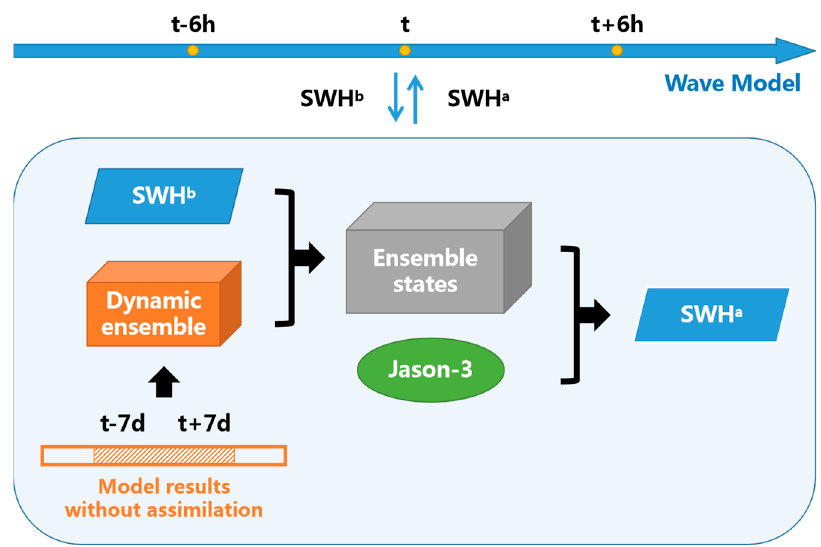
Figure 2. Flowchart of wave assimilation.